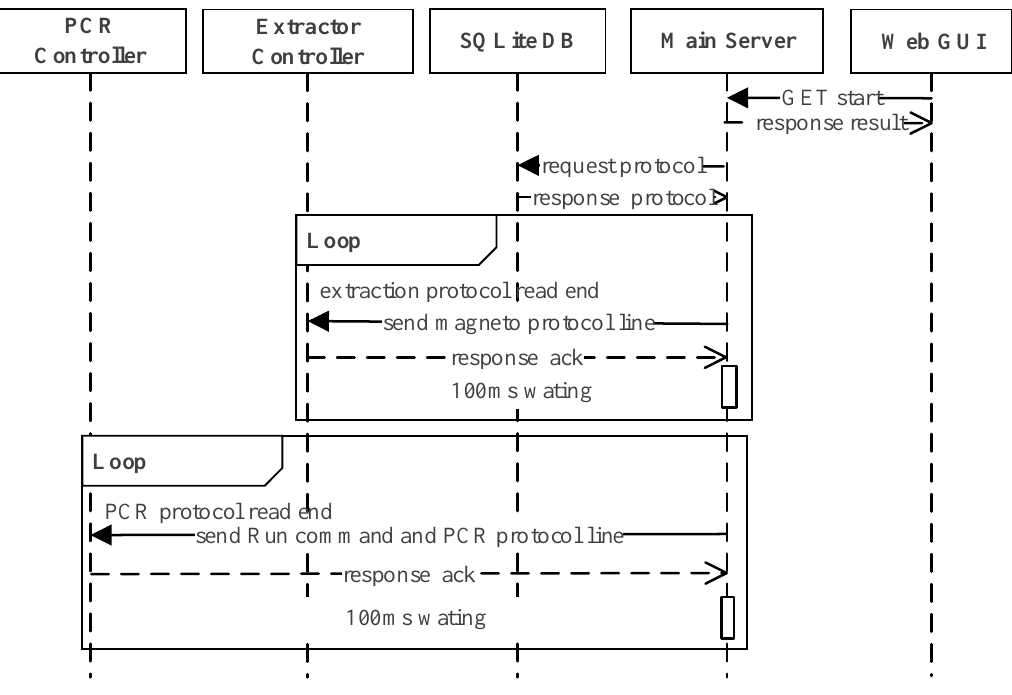
Figure 7. The interaction scenario during the whole molecular diagnosis in sequential order.